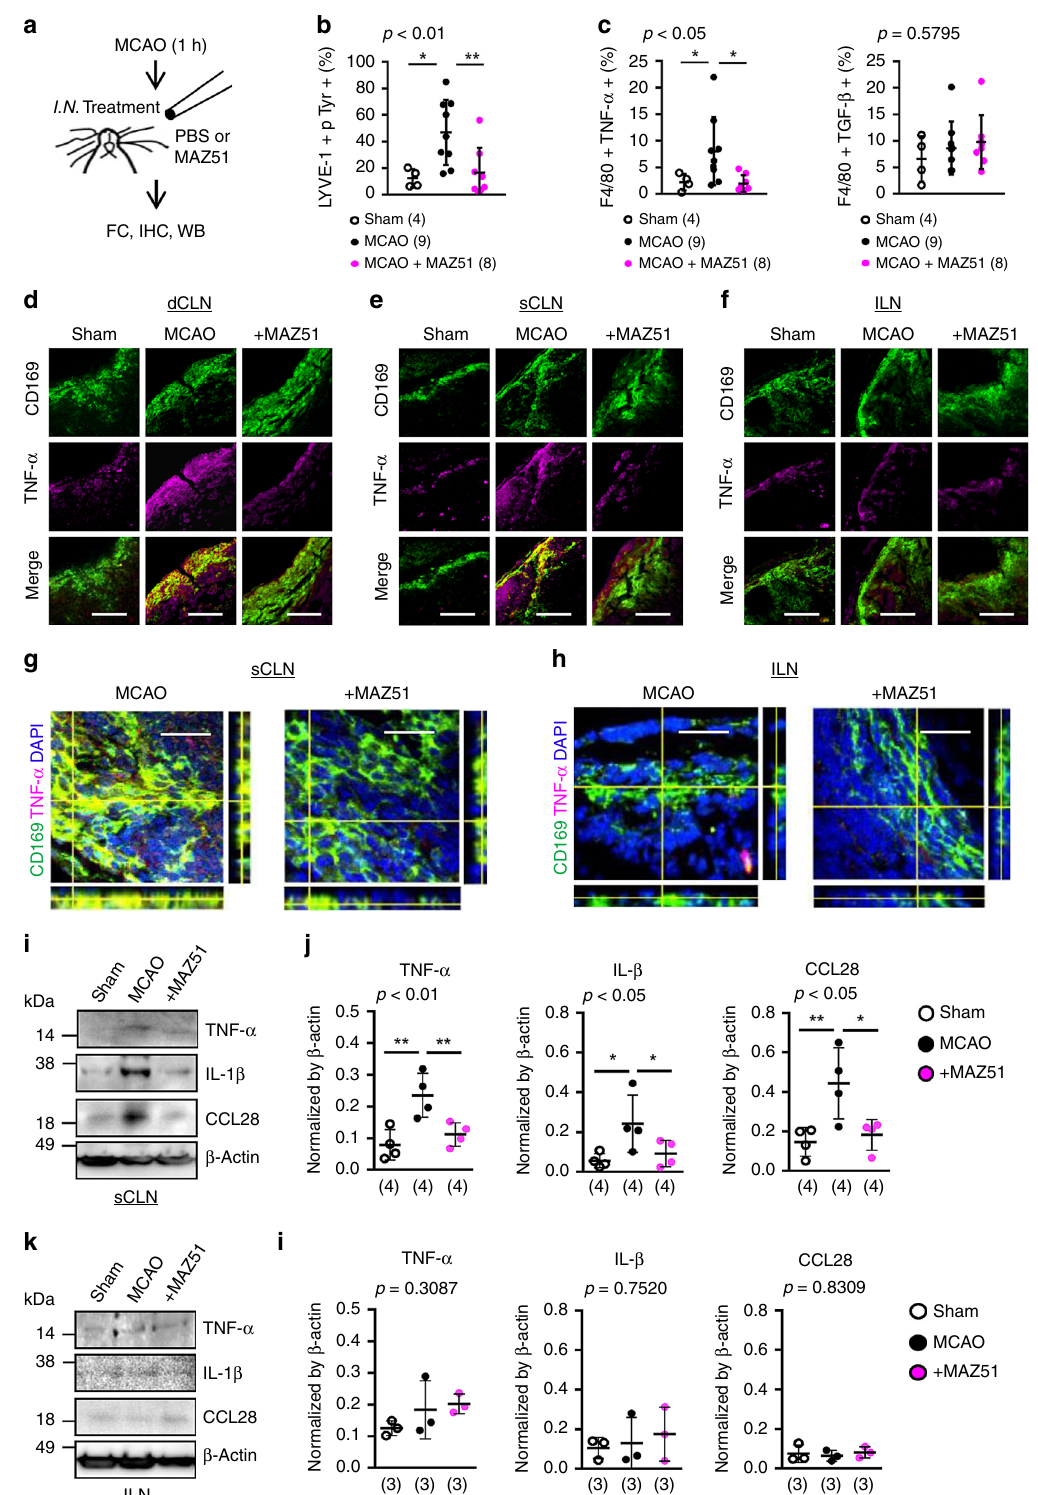
was dropped and coverslips were put on sections for imaging. IgG staining was performed by a combination of M.O.M kit (BMK-2202, Vector Laboratories) and ABC peroxidase staining kit (32020, Thermo Fisher Scienti fi c). Fresh frozen brain sections were initially fi xed with 4% paraformaldehyde for 10 min at room tem- perature. After blocking endogenous enzyme activity with BLOXALL blocking solution for 10min, M.O.M mouse Ig blocking reagent was applied on sections for 1 h at room temperature, followed by washing sections with PBS twice. Then, biotinylated anti-mouse IgG was applied for 10 min. After washing sections